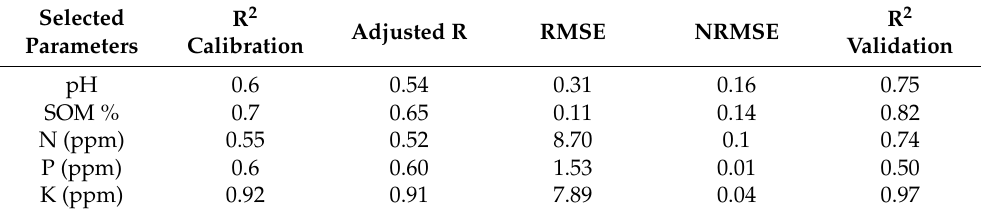
Table 4. Model validation of soil property values obtained from S2A image.